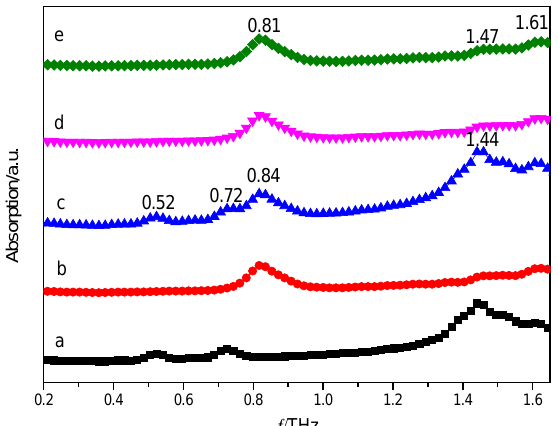
Figure 2. THz spectra of PZA ( a ); 3-hydroxybenzoic acid (3-hBA) ( b ); physical mixture ( c ); solvent cocrystal ( d ); and grinding cocrystal ( e ).